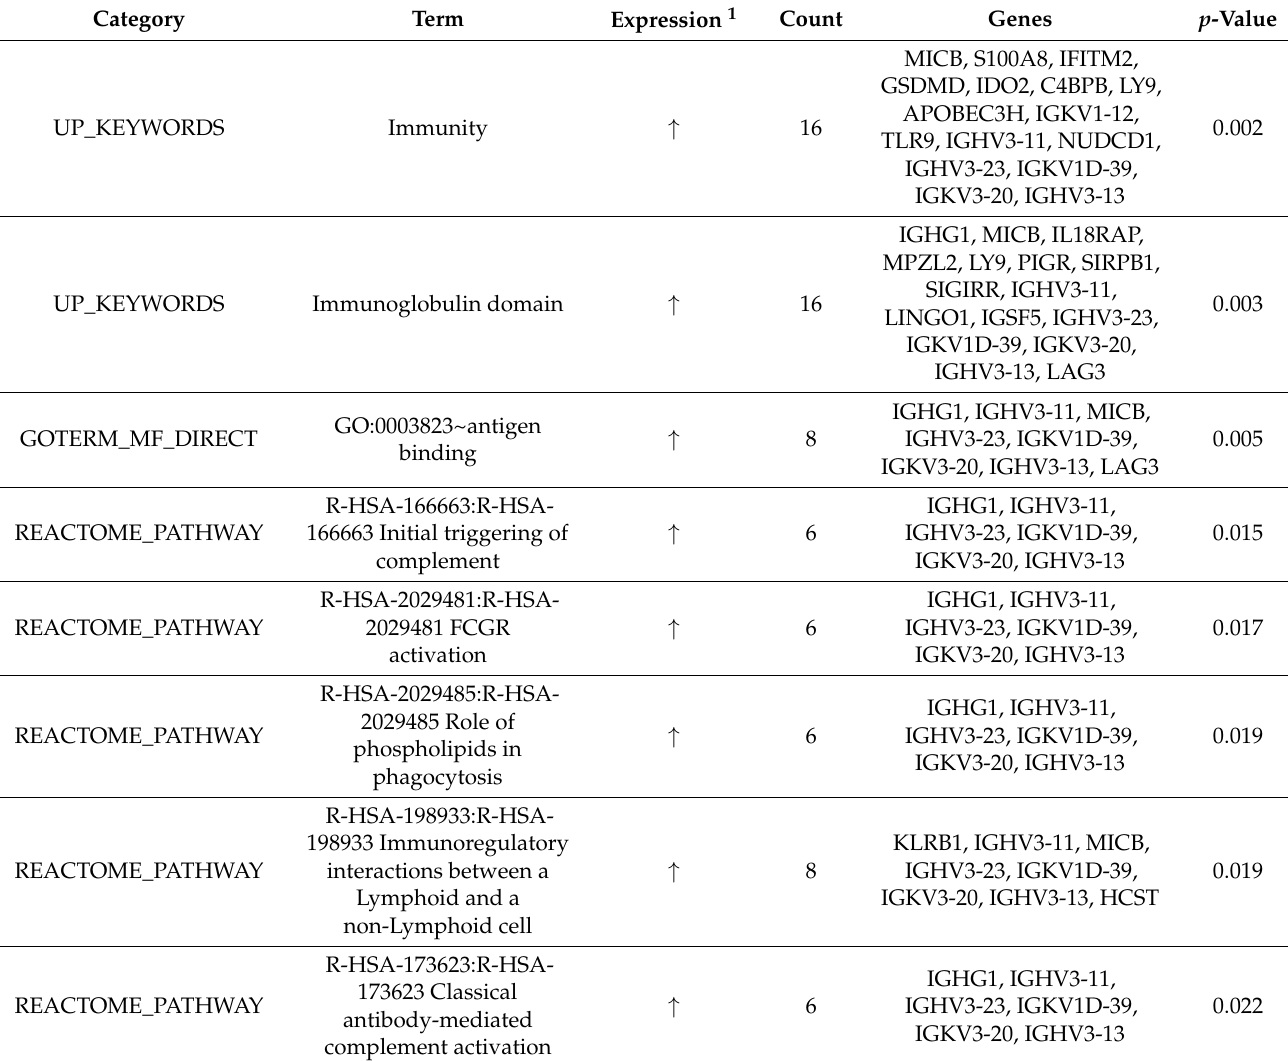
Table 3. Enrichment analysis of up-regulated (N = 197) and down-regulated (N = 234) genes in Cluster 1 compared with Cluster 2 MBCs. Only terms considered as the most representative and interesting among the significant ones are reported. Category Term Expression 1 Count Genes p